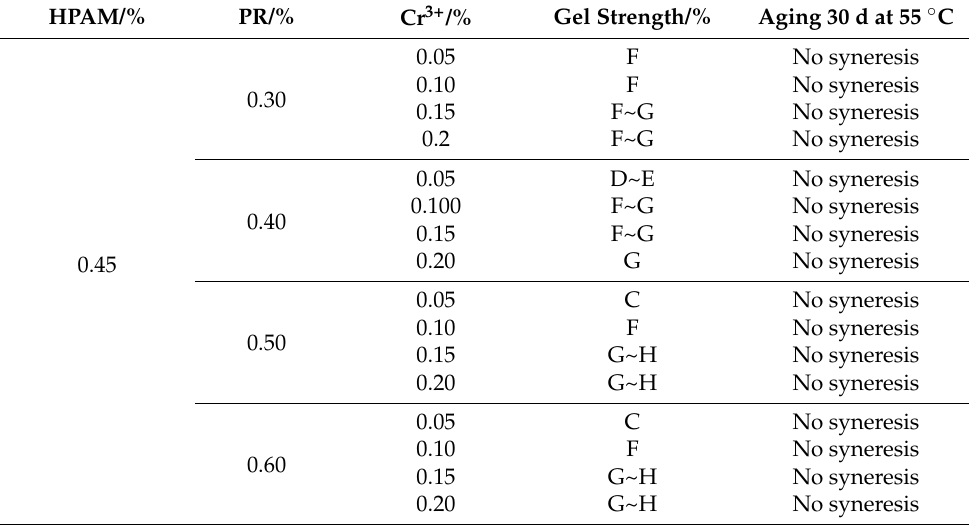
Gel strength and long-term thermal stability of the gel system prepared via 0.45% HPAM + PR and Cr 3+